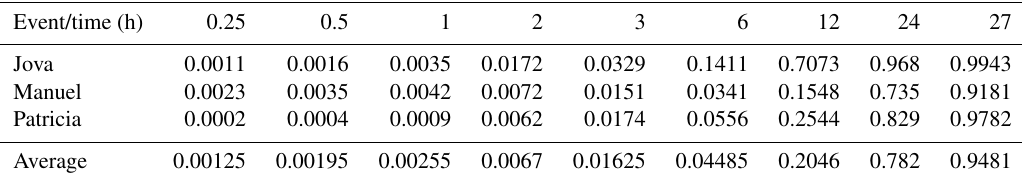
Table 2. Normalized accumulated rains at progressive time steps. Event/time